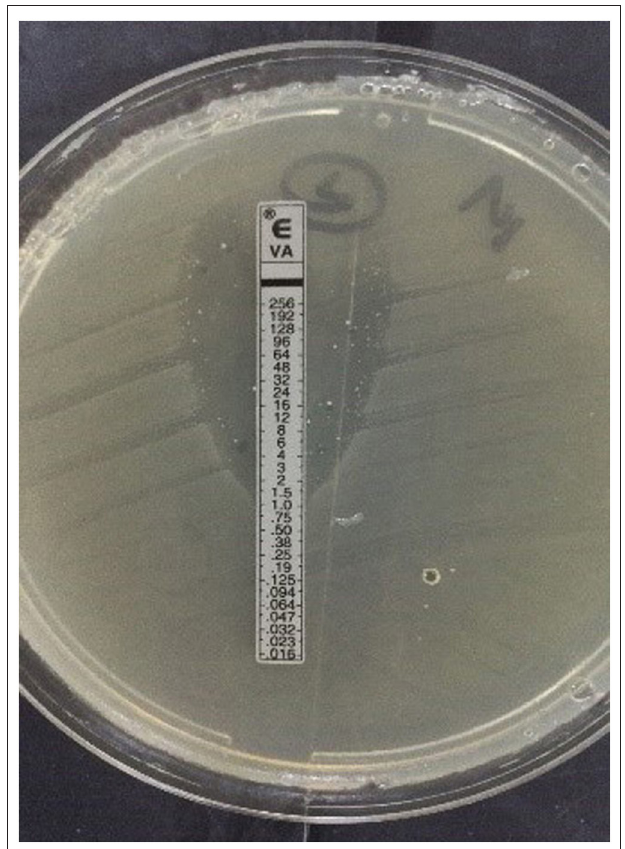
FIGURE 2 | Vancomycin heterogeneous resistant Enterococcus carrying vanM obtained from antibiotic free medium.